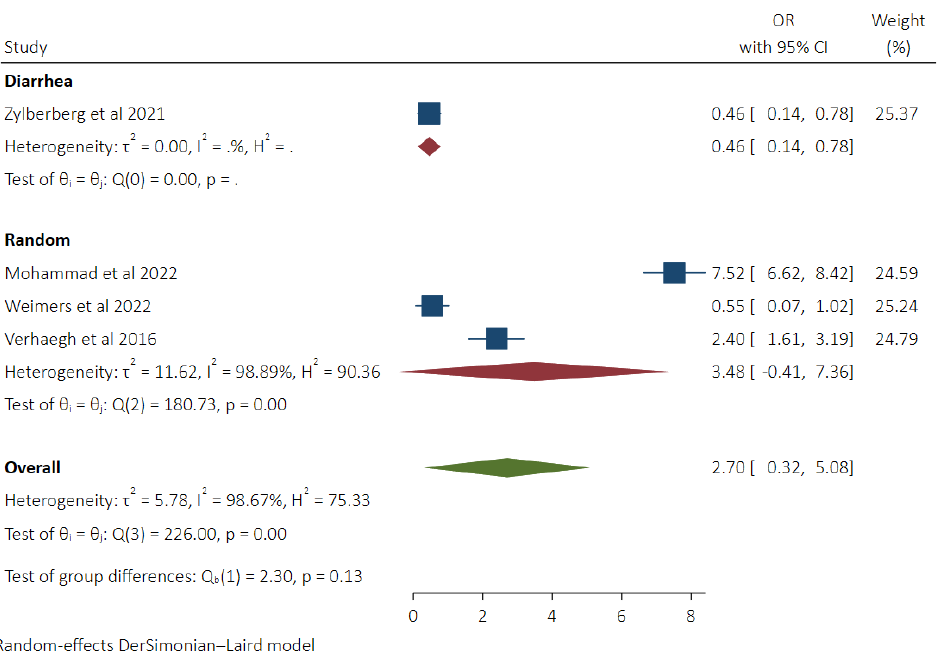
Figure 5. Pooled odds of MC in Statin users with subgroup analysis based on control groups (Diarrhea vs. Random Control) [8,9,17–19,21,22].